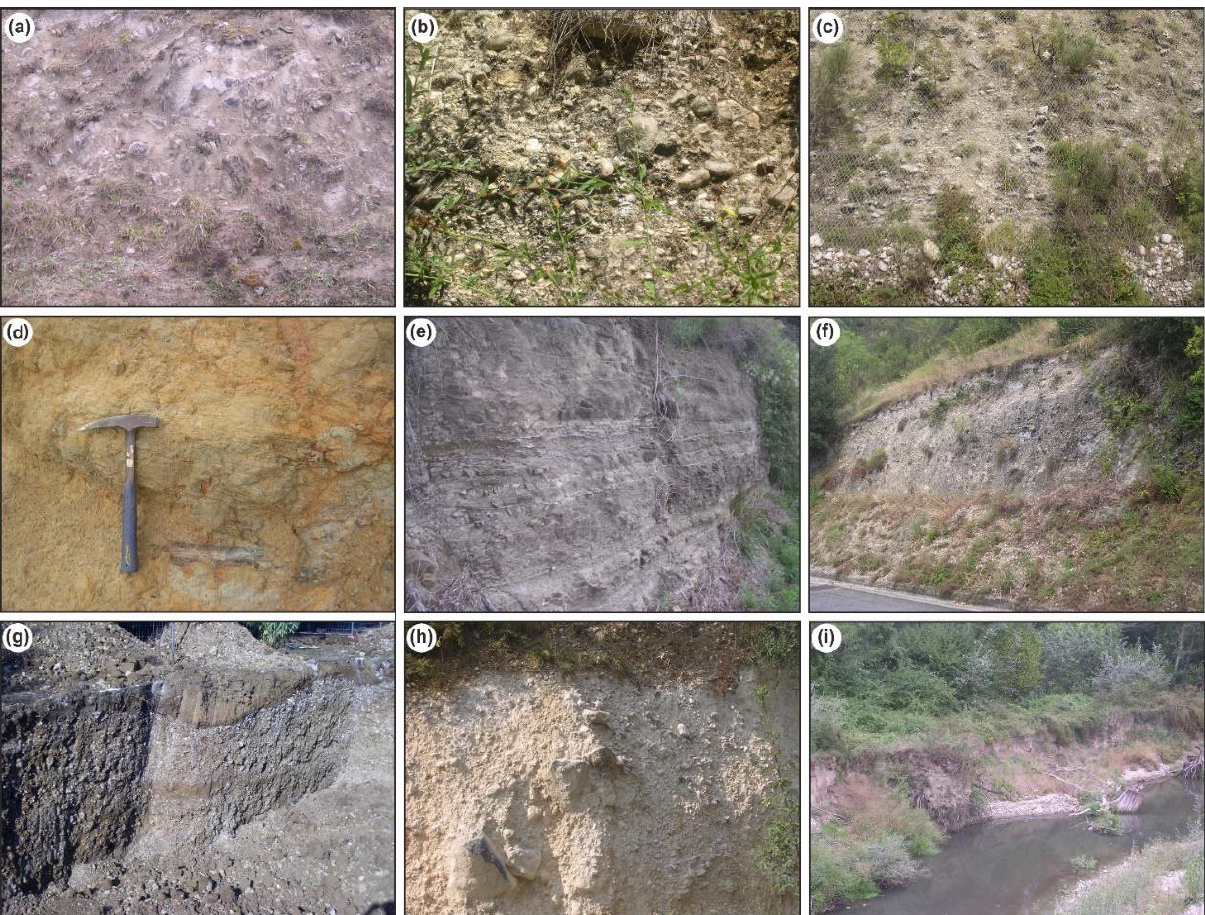
Figure 5. Photo documentation of continental deposits. ( a ) Coarse loose conglomeratic deposits — 2e; ( b ) heterometric gravelly and conglomeratic deposits — 2c; ( c ) heterometric conglomeratic deposits supported by sandy-silty matrix — 2b; ( d ) alternances of grey-blue clayey-silty and yellowish silty-sandy deposits — 2a; ( e ) fine to coarse grey cineritic with heterometric carbonate clasts — 1m; ( f ) clast-supported massive conglomeratic deposits — 1h; ( g ) heterometric calcareous gravelly deposits in sandy matrix — 1d; ( h ) slope and landslide deposits — 1b; ( i ) recent fluvial and alluvial deposits — 1a. Numbers (2e, 2c, 2b, 2a, 1m, 1h, 1d, 1b, 1a) refer to the legend in Figure 4.